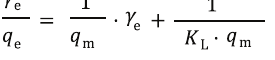
The R value in this study was 0.045, confirming that MB L adsorption onto poplar sawdust under the studied conditions was a favourable process. When experimentally obtained values were compared to the q values calculated q m_exp m_cal based on the given Langmuir equation, a discrepancy could be seen. However, as already mentioned, experimentally ) in this study are obtained adsorption capacities (q m_exp comparable to those reported by other authors (Table